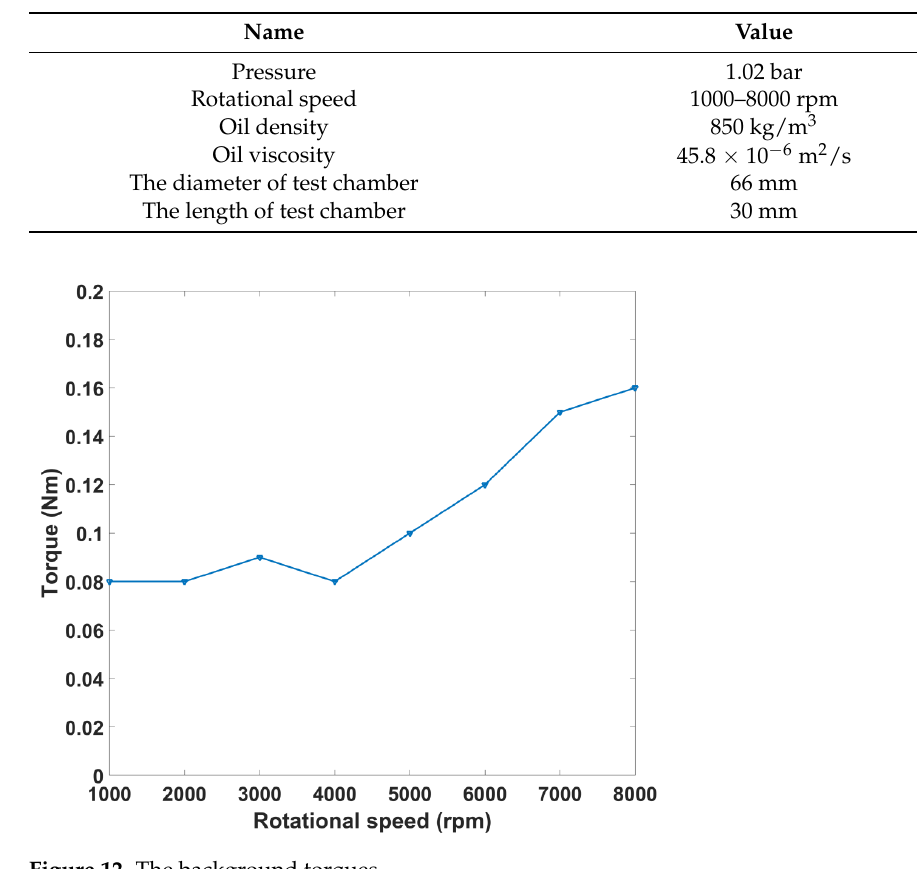
Figure 12. The background torques.